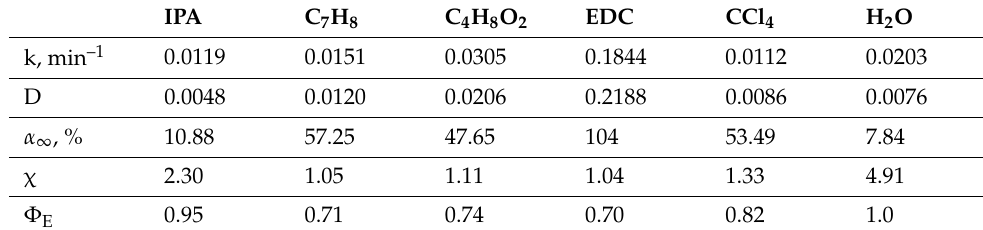
Table 9. Thermodynamic properties of the ‘composite–liquid’ system for the 0047 (Hybrid) blanket.